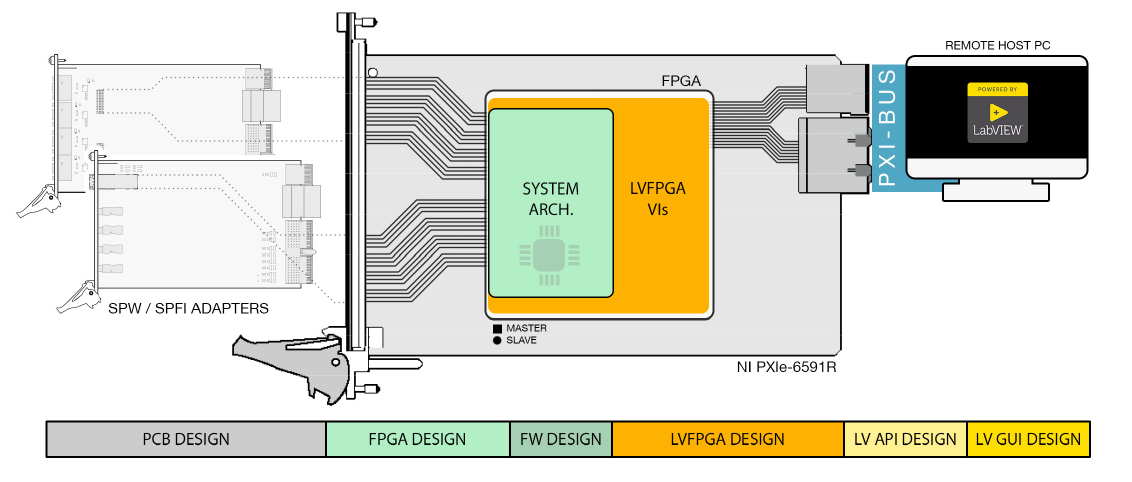
Figure 2. System overall organization and highlight of all encompassed design